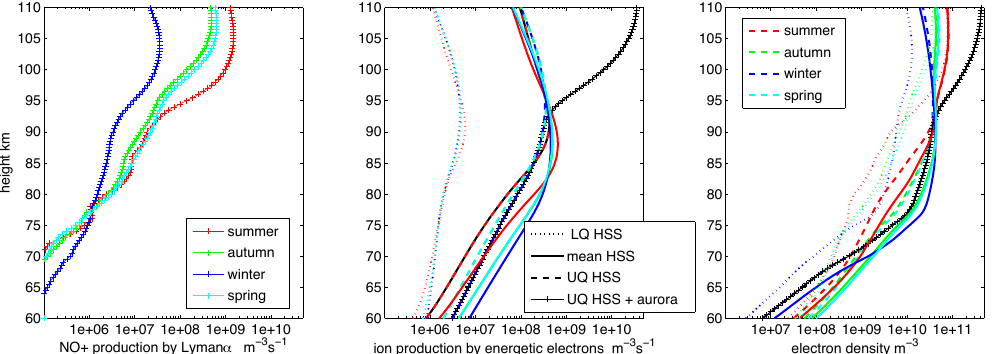
Figure 3. Seasonal averages of model calculations, for the location of Maitri Station, Antarctica. Left panel: daily average ionization rate of NO by solar Lyman α radiation, including nightglow. Middle panel: daily average ionization rate by energetic electrons. Right panel: resulting daily average electron density. Solid lines in the middle and right-hand panels are for mean-HSS fluxes, dotted lines are for LQ-HSS and dashed lines are for UQ-HSS.